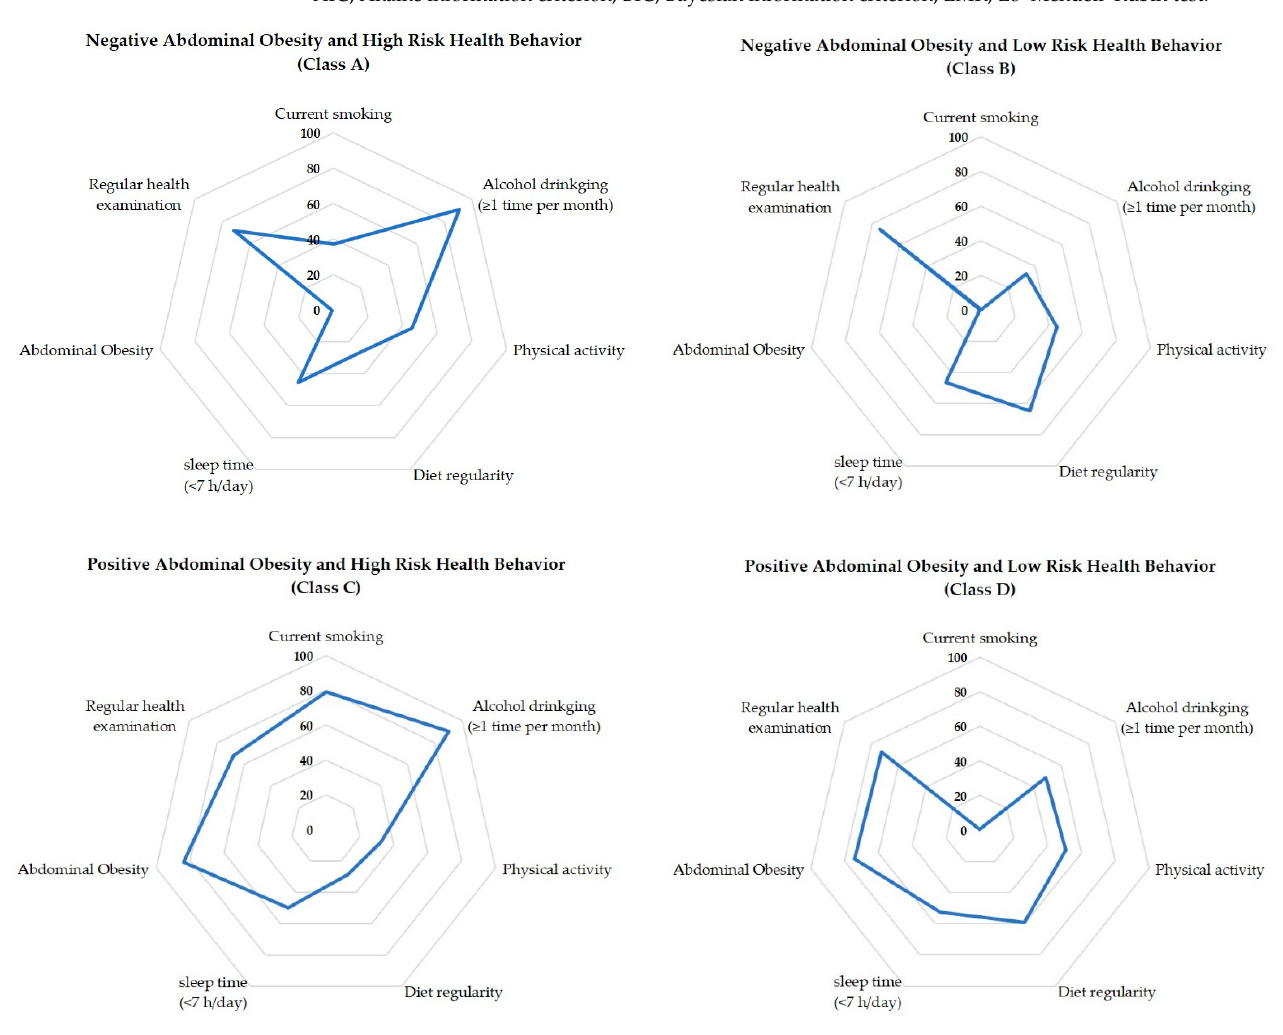
Figure 3. Item-response probabilities of health behaviors for the four-class model.